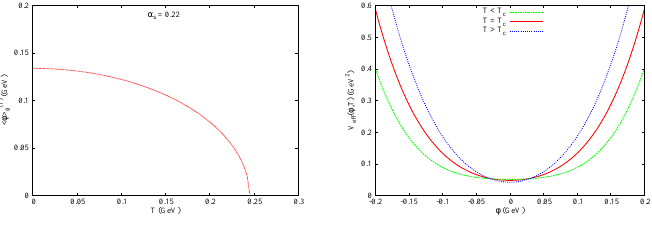
Figure 1. (Color online.) (a) The behavior of monopole condensate ( < φ > ( T ) the finite temperature e ff ective potential V ef f ( φ, T ) as a function of monopole condensate ( φ ) for the coupling α s = 0 .